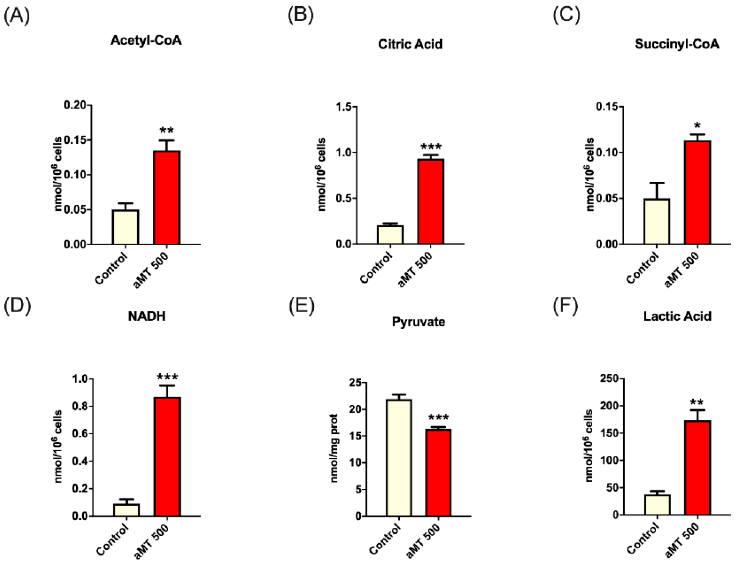
Figure 1. Upregulation by melatonin of key TCA cycle metabolites in HNSCC cell line Cal-27. Metabolomic study of intracellular levels of acetyl-CoA ( A ), citric acid ( B ), succinyl-CoA ( C ), NADH ( D ), and lactate ( F ). Pyruvate levels were measured using a colorimetric test ( E ). Treatment groups included vehicle (control) and melatonin (aMT) at a concentration of 500 µM. n = 4 per group. Data are presented as mean ± SEM. * p < 0.05, ** p < 0.01, *** p < 0.001 vs. control group.